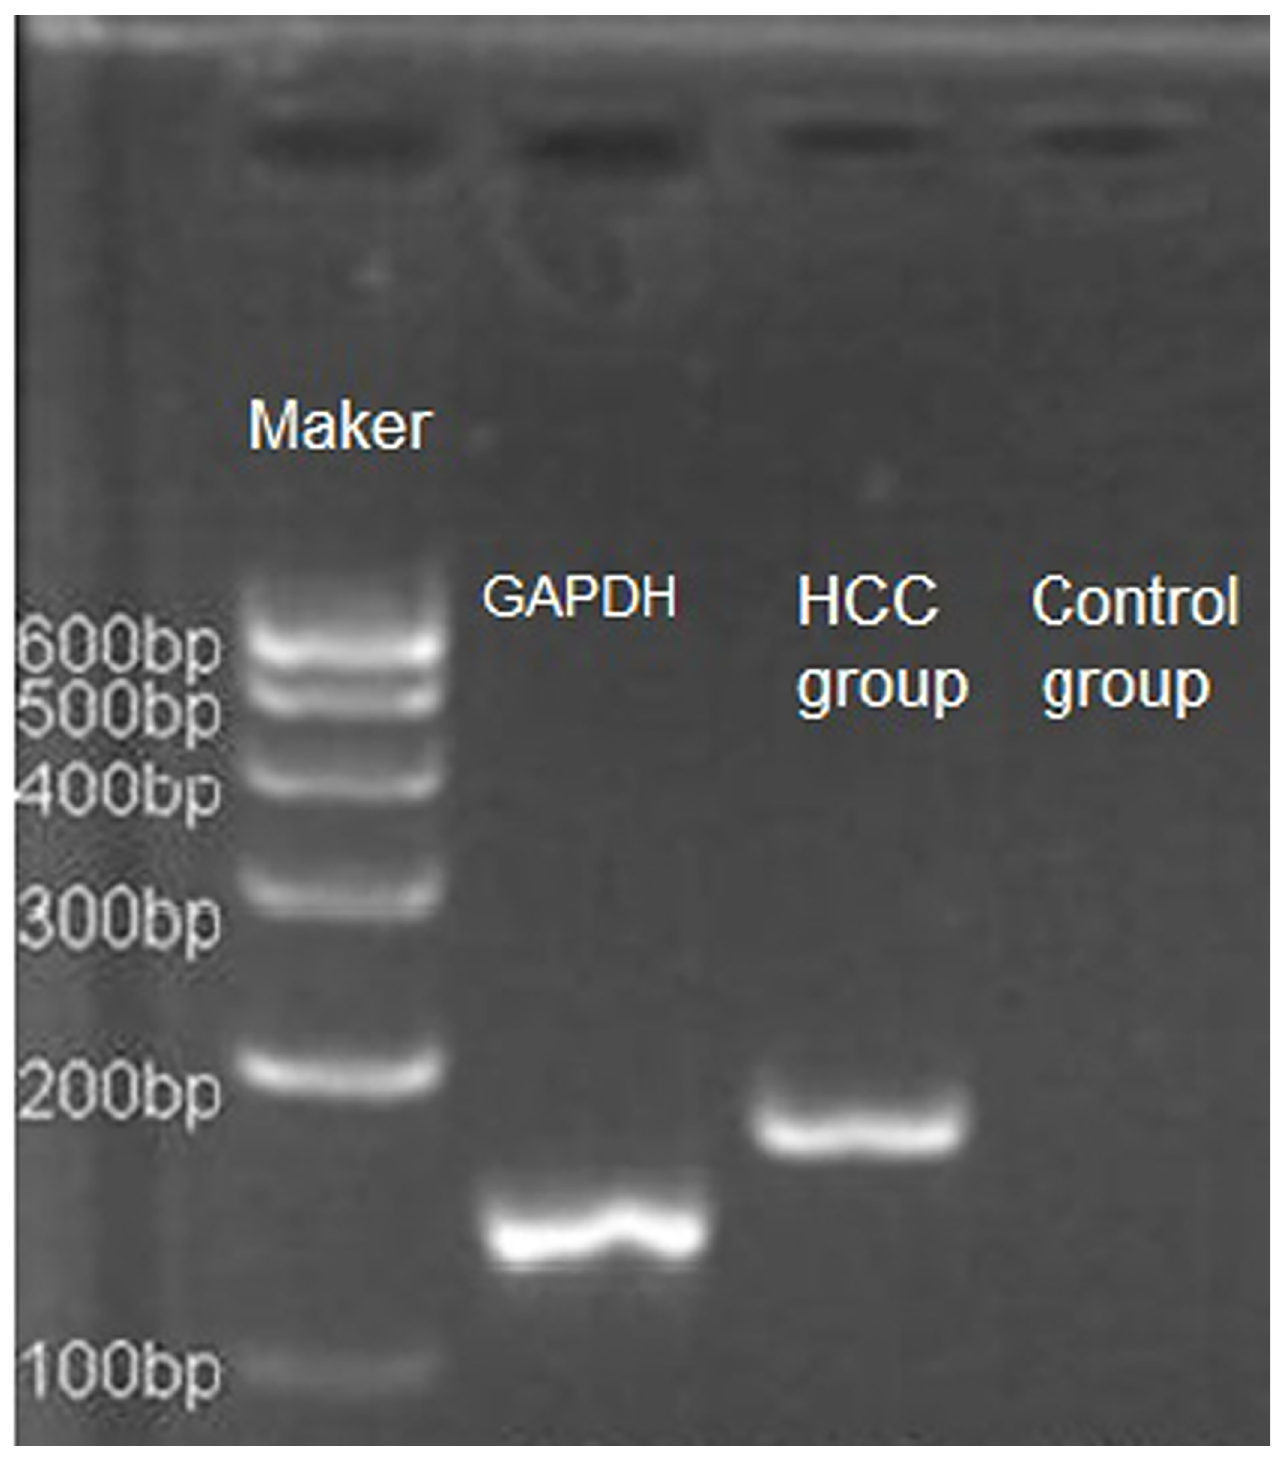
Fig 3. Expression of CK-19 mRNA in HCC tissues (RT-PCR).